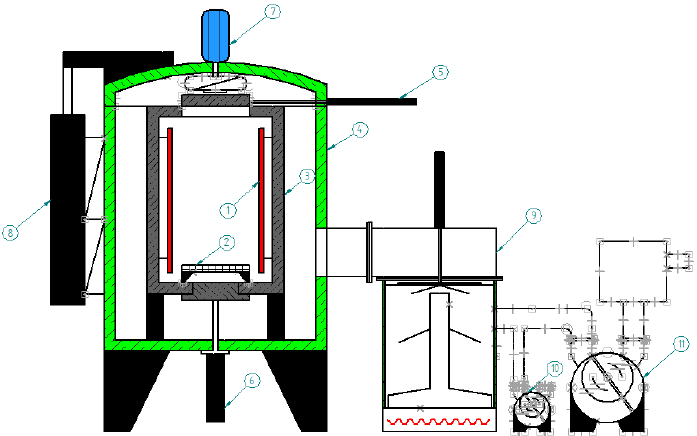
Figure 1. Experimental set for the pyrolysis under vacuum. Legend: 1—electrical resistance; 2— support for the batch; 3—heating chamber; 4—external jacket; 5—pneumatic cylinder for drive up;